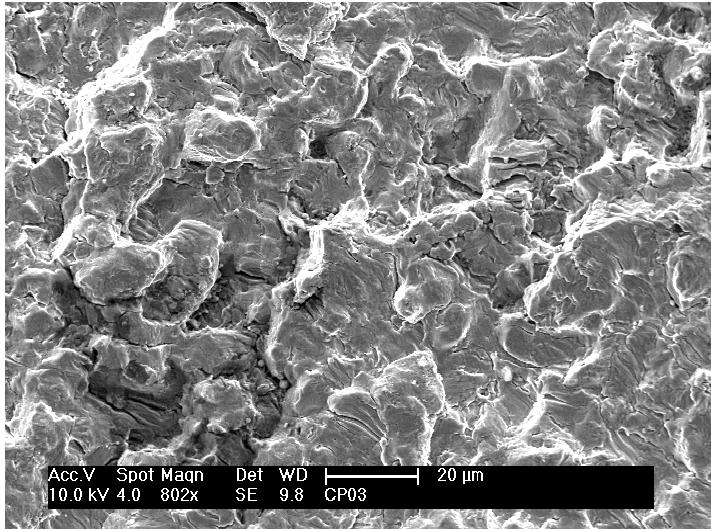
Figure 9. Scanning electron micrograph of the fracture surface of the plasma nitrided specimen that was fatigue tested at 610 MPa and 233,000 cycles to failure.